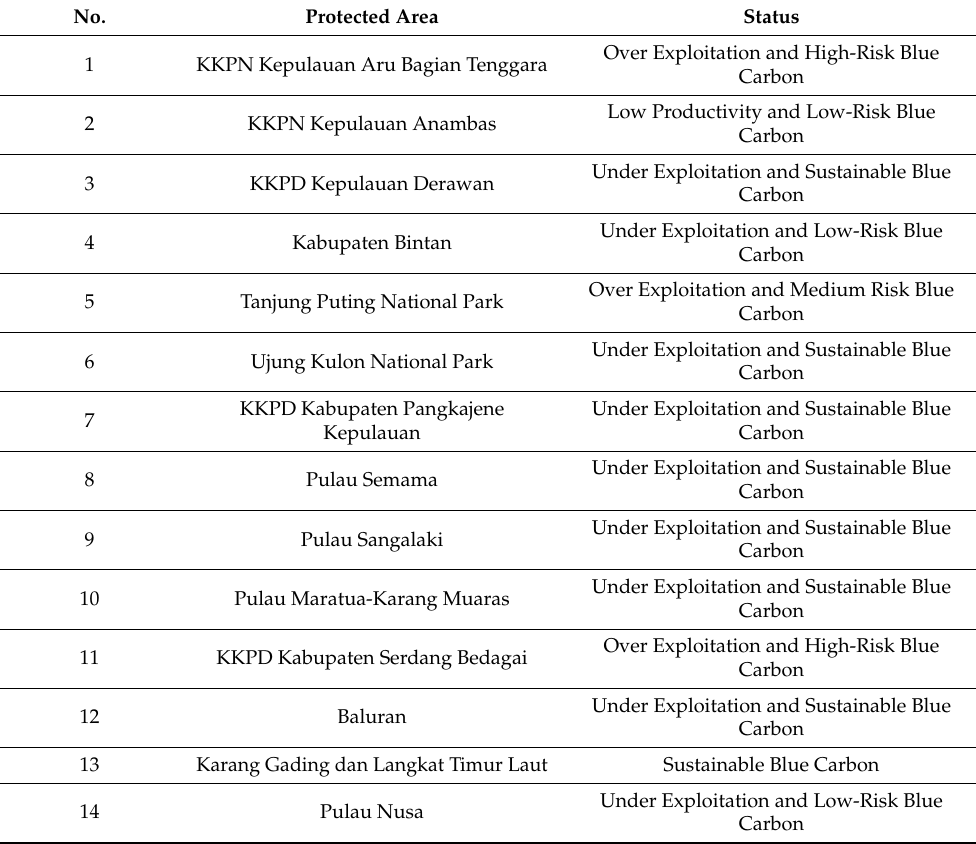
Table 4. Status of the 14 MPAs based on Fauzi et al., 2021 [23]. No. Protected Area Status 1 KKPN Kepulauan Aru Bagian Tenggara